Question: Does the figure show an increasing or a decreasing trend?
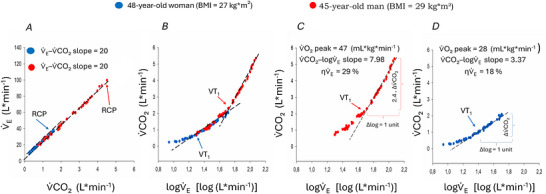
Answer: increasing